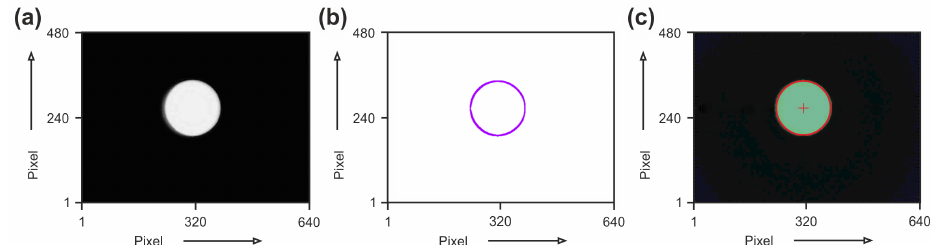
Figure 3. Illustration of individual steps in KSO-STREAMS image processing to derive a circular fit to solar-limb pixels: (a) grayscale- transformed solar disk image (original KSO-STREAMS picture is shown as background in panel c ); (b) solar-limb pixels (purple) identified through the application of a Sobel operator to panel a ; and (c) the best fitting circle (red) to solar-limb pixels from panel b derived by a least-squares fitting approach superimposed on the original KSO-STREAMS picture. The red cross in panel c marks the center of the fitted